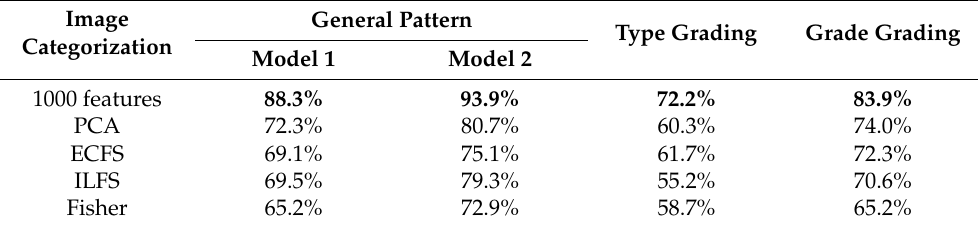
Figure 22. The confusion matrix with for grade grading using 1000 deep learning features. Table 7. Testing accuracy results using 30 most significant automatic features.